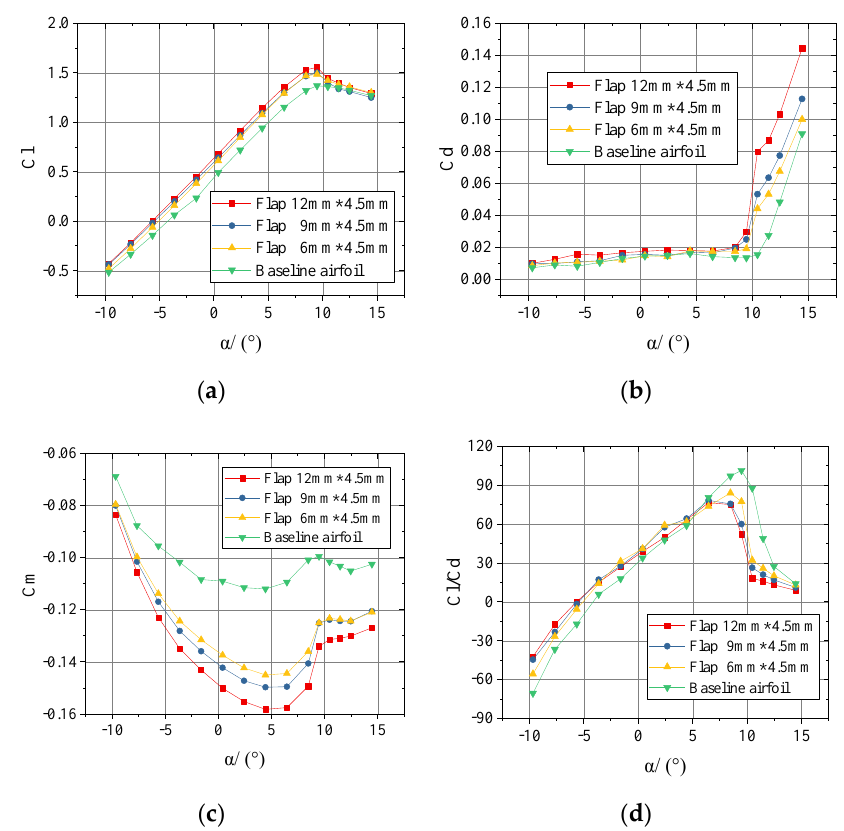
Figure 10. Variation of the aerodynamic characteristics with different heights of Gurney flaps (uniform flow, Re: 0.8 × 10 6 ). ( a ) Lift coefficient comparison; ( b ) drag coefficient comparison; ( c ) pitching-moment coefficient comparison; ( d ) lift-to-drag ratio comparison.